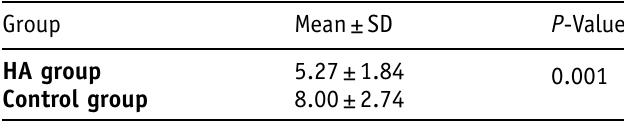
Table V. Total numbers of analgesic consumption in 30 patients for analgesics in 3